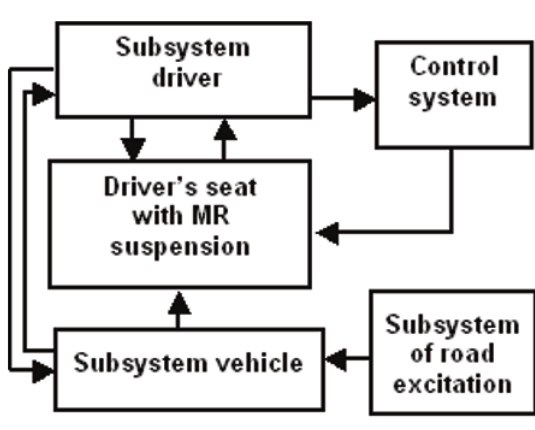
Fig. 5. Complex human-seat-vehicle system Figure 5. Complex human-seat-vehicle system analyzed analyzed model.